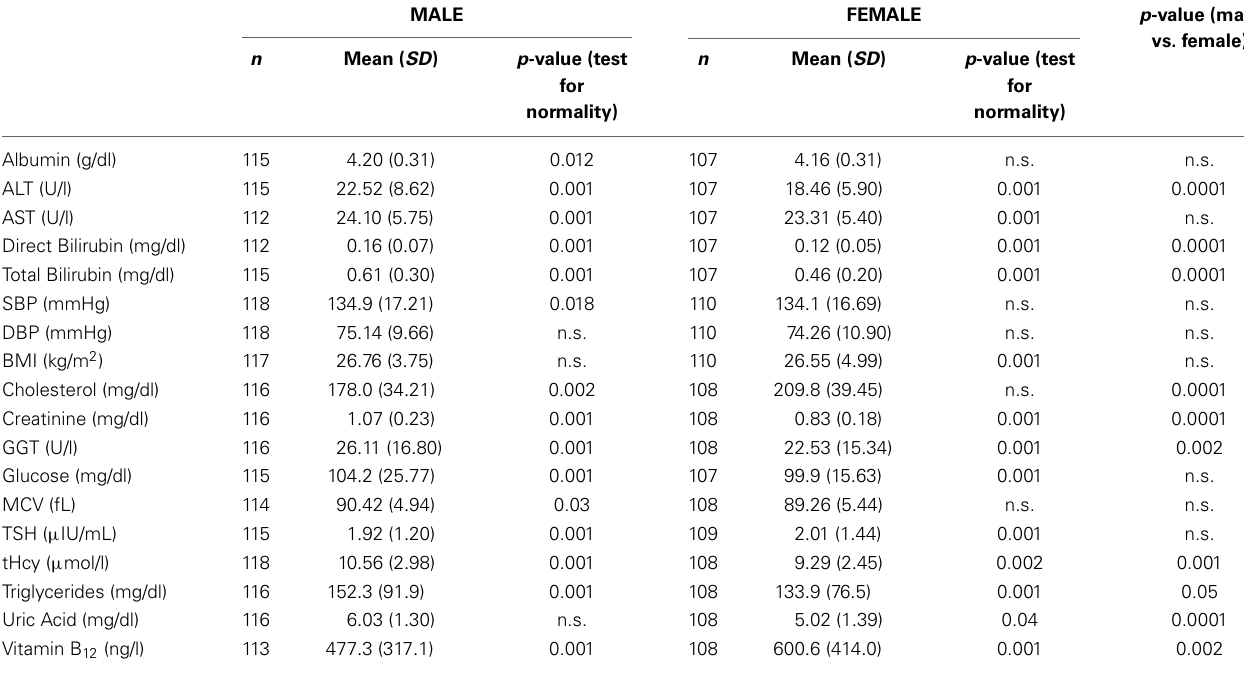
Table 1 | Baseline characteristics of all measured physiological and clinical chemistry parameters in male and female test samples.